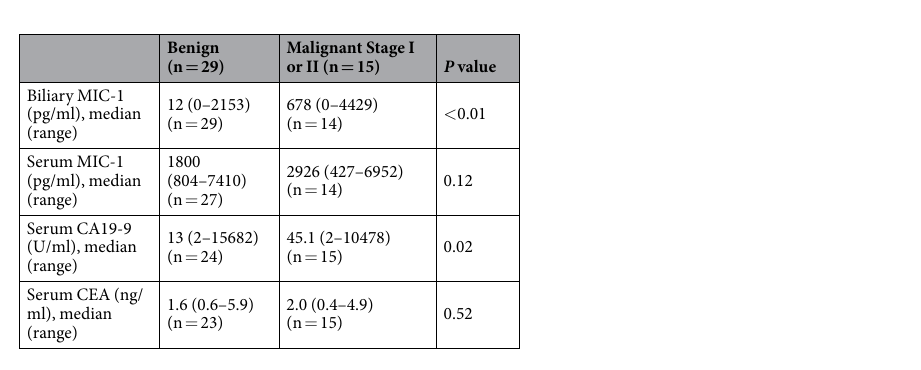
Table 3. Comparison of each marker between the benign and early malignant groups. MIC-1 , macrophage inhibitory